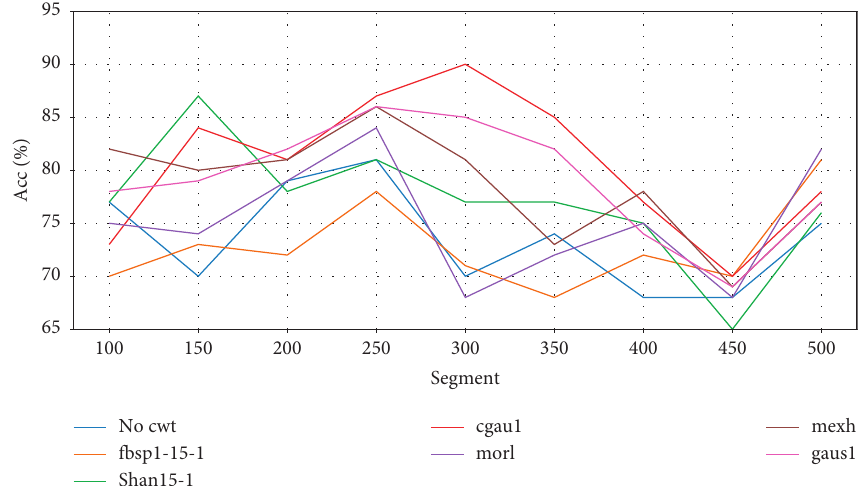
Figure 3: The accuracies of different algorithms by matching CWTs with different segment lengths.